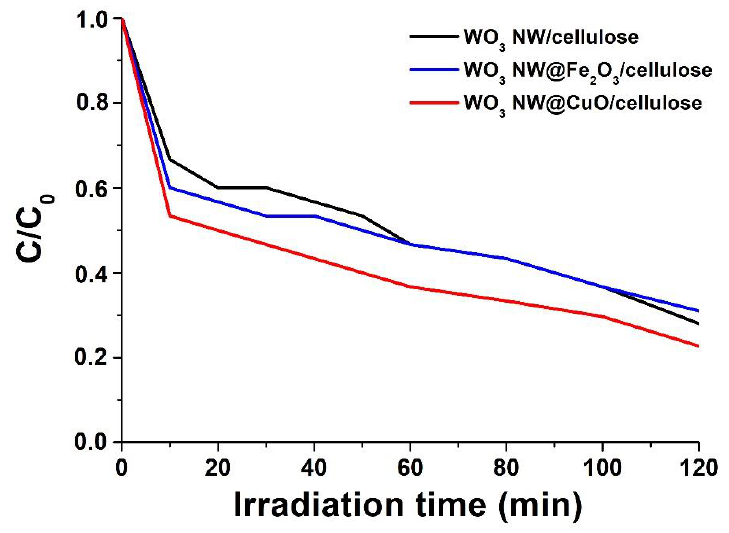
Figure 6. Photocatalytic performance of WO 3 NW/cellulose (black curve), WO 3 NW@Fe 2 O 3 /cellulose (blue curve), and WO 3 NW@CuO/cellulose (red curve) hybrid membranes in MB degradation reaction.